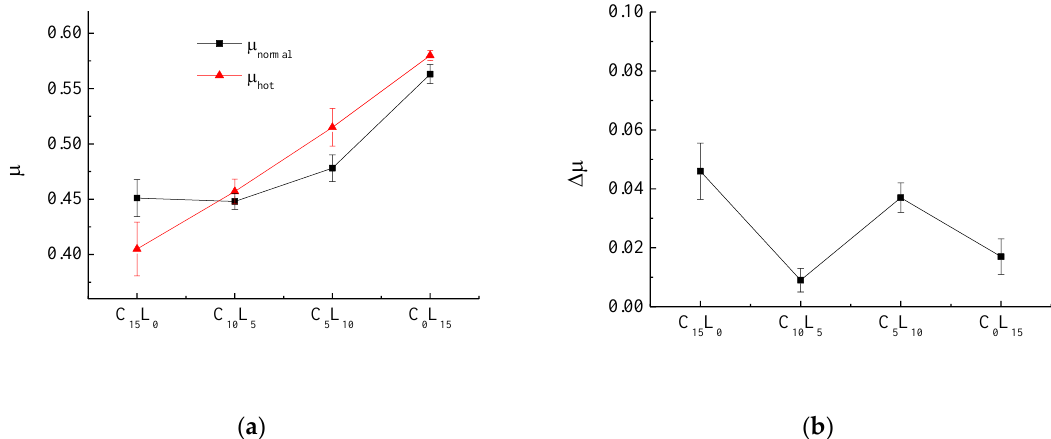
Figure 3. Variation in µ normal , µ hot and ∆ µ ( µ fluctuations) with different wt % of Cu and La 2 O 3 for brake composites: ( a ) µ normal and µ hot ; ( b ) ∆ µ.